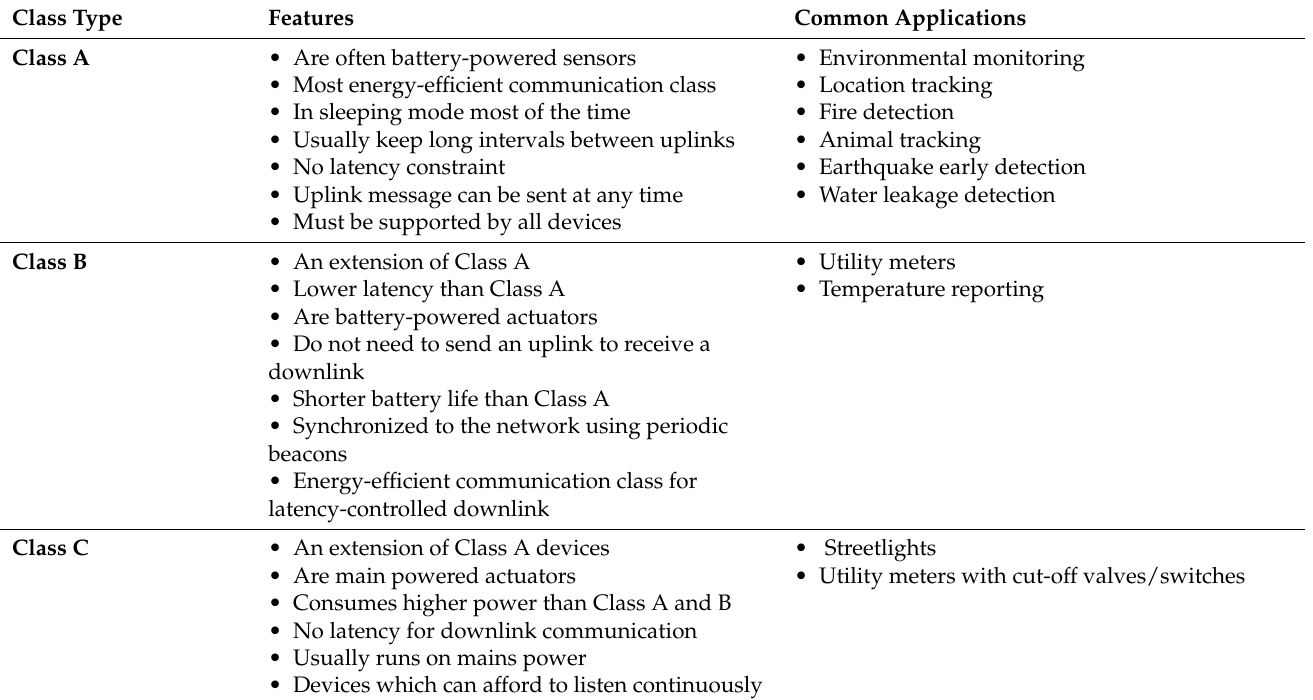
Table 4. LoRaWAN Device Classes Features and Applications [131,132].